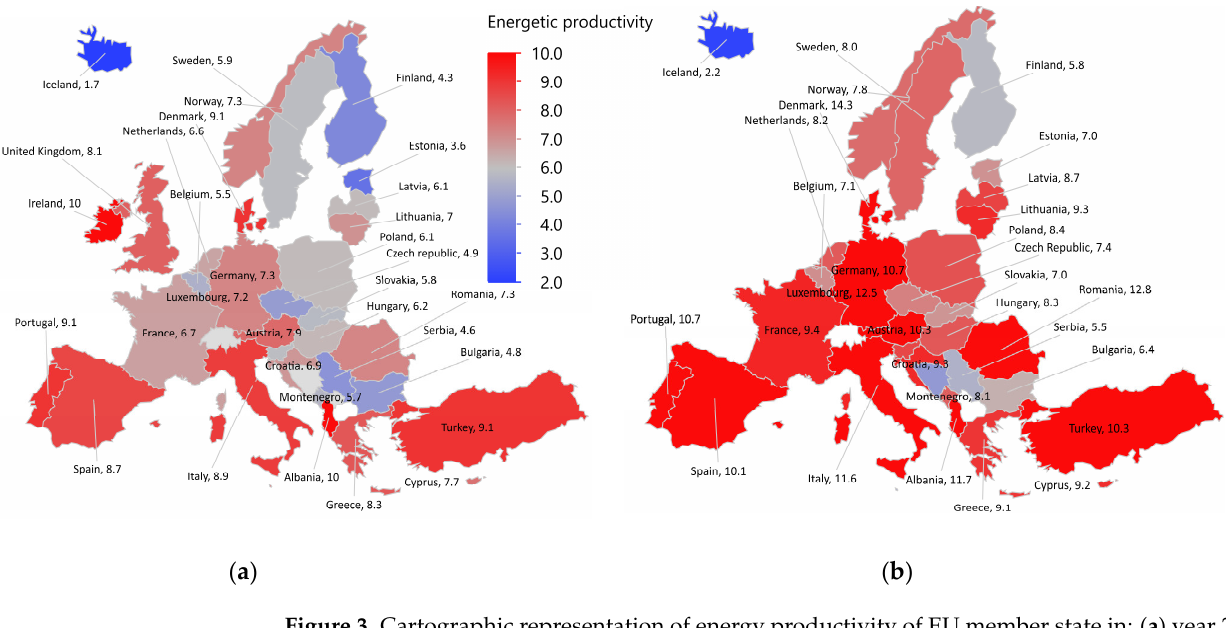
Figure 3. Cartographic representation of energy productivity of EU member state in: ( a ) year 2010 and ( b ) year 2020. Source: own processing according to [19], processing in JMP. Note: The legend applies to both ( a , b ).